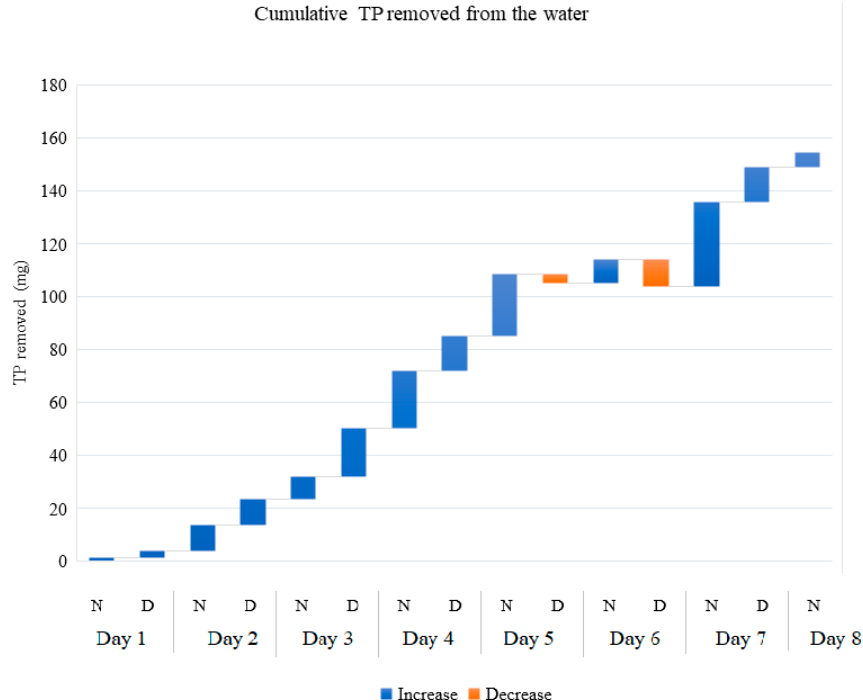
Figure 7. Cumulative Total Phosphorus removed from 70 L of aquaculture effluent every 12 h. N (Night) indicates the Total Phosphorus removed between 8:00 pm and 8:00 am; D (Day) indicates the Total Phosphorus removed between 8:00 am and 8:00 pm. The graph shows the average of three replicates.